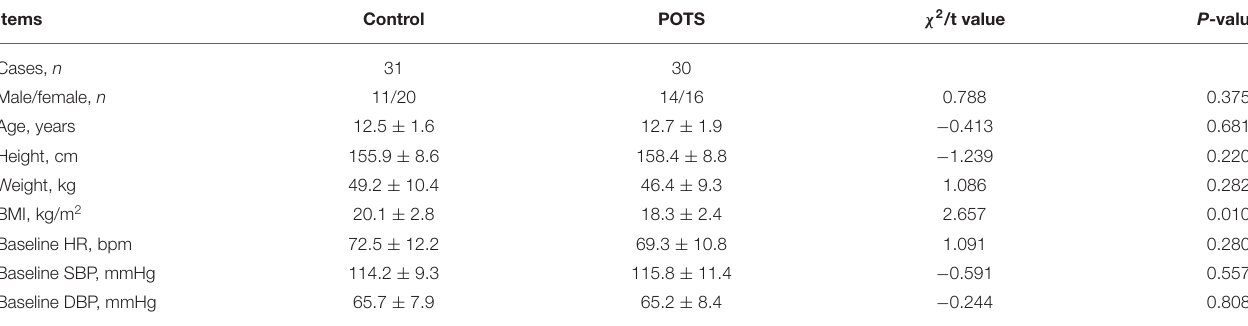
TABLE 1 | Baseline characteristics of the postural tachycardia syndrome (POTS) and control groups. Items Control POTS χ 2 /t value P